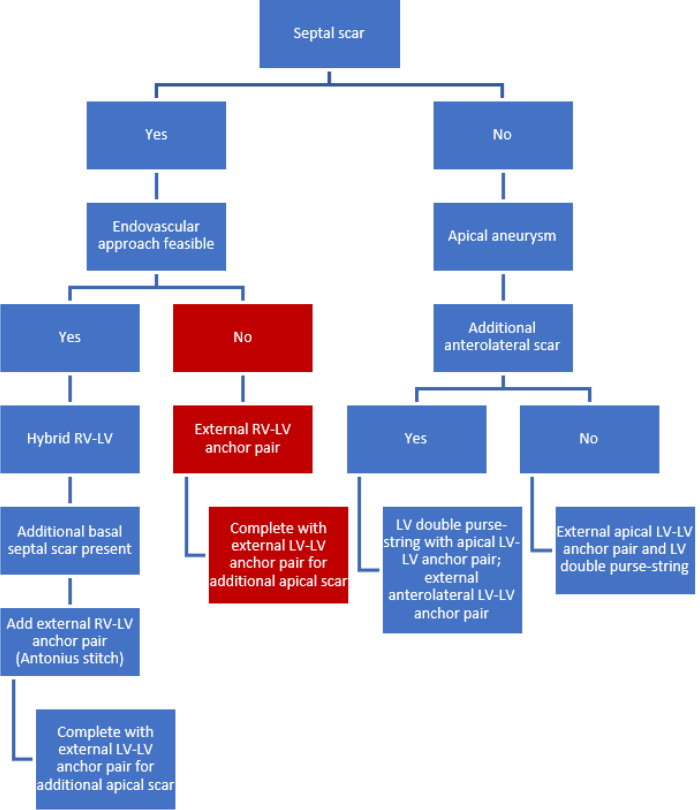
Figure 1. Flowchart of technical considerations based on scar distributions. Colored in red is the bail-out procedure in case the indicated hybrid endovascular approach is considered non-feasible because of increased procedural risk. Abbreviations: LV, left ventricle; RV, right ventricle.